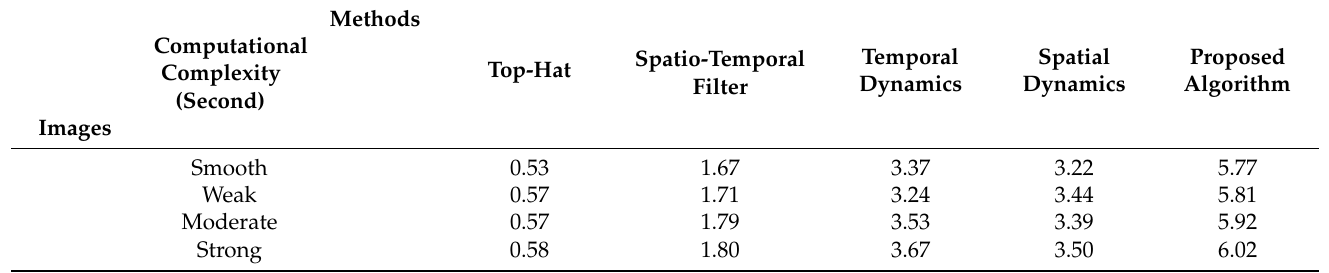
Table 1. The comparison of the computational complexity of each